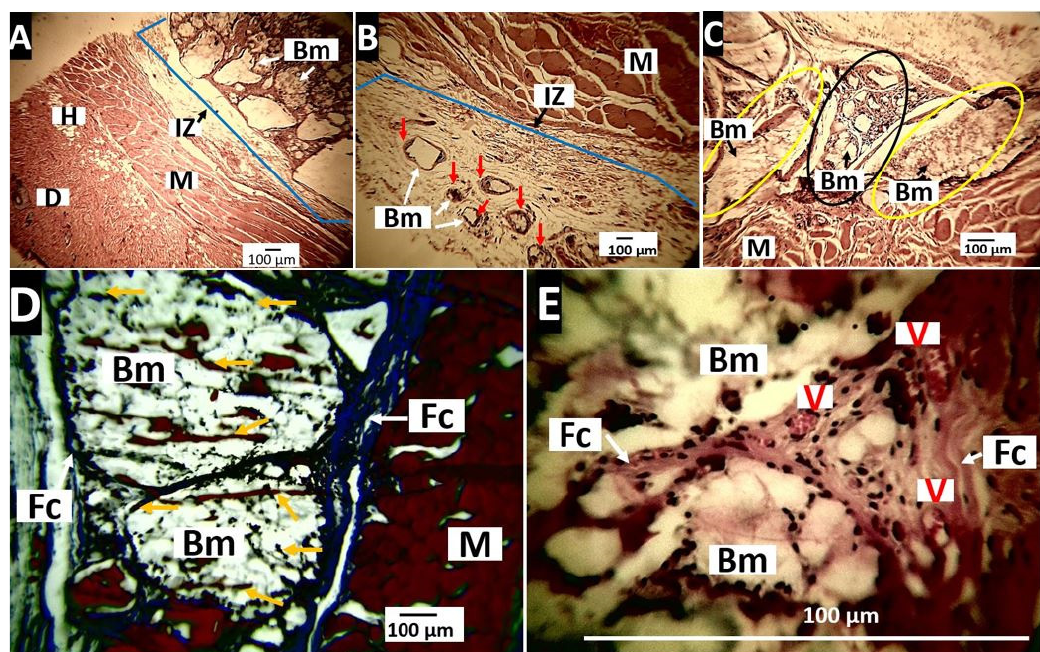
Figure 14. Nanocomposites PLA/n-BGs 5 wt.% implanted at 30, 60, and 90 days. ( A ): 30 days, Hematoxylin-Eosin technique, 4×. ( B ): 60 days, Masson’s Trichrome technique, 4×. ( C ): 90 days, Masson’s Trichrome technique 10×. Black oval: particles of biomaterial in the process of fragmentation. Yellow oval: biomaterial particles with surface changes in the process of degradation. ( D ): 60 days, Masson’s Trichrome technique, 10×. ( E ): 60 days, Hematoxylin Eosin technique 100×. D: dermis. H: hypodermis. M: muscle. IZ: implantation zone. Bm: biomaterial. Fc: fibrous capsule. Red arrows: particles of the material in the process of degradation/reabsorption. Yellow arrows: collagen I fiber. V: blood vessel.